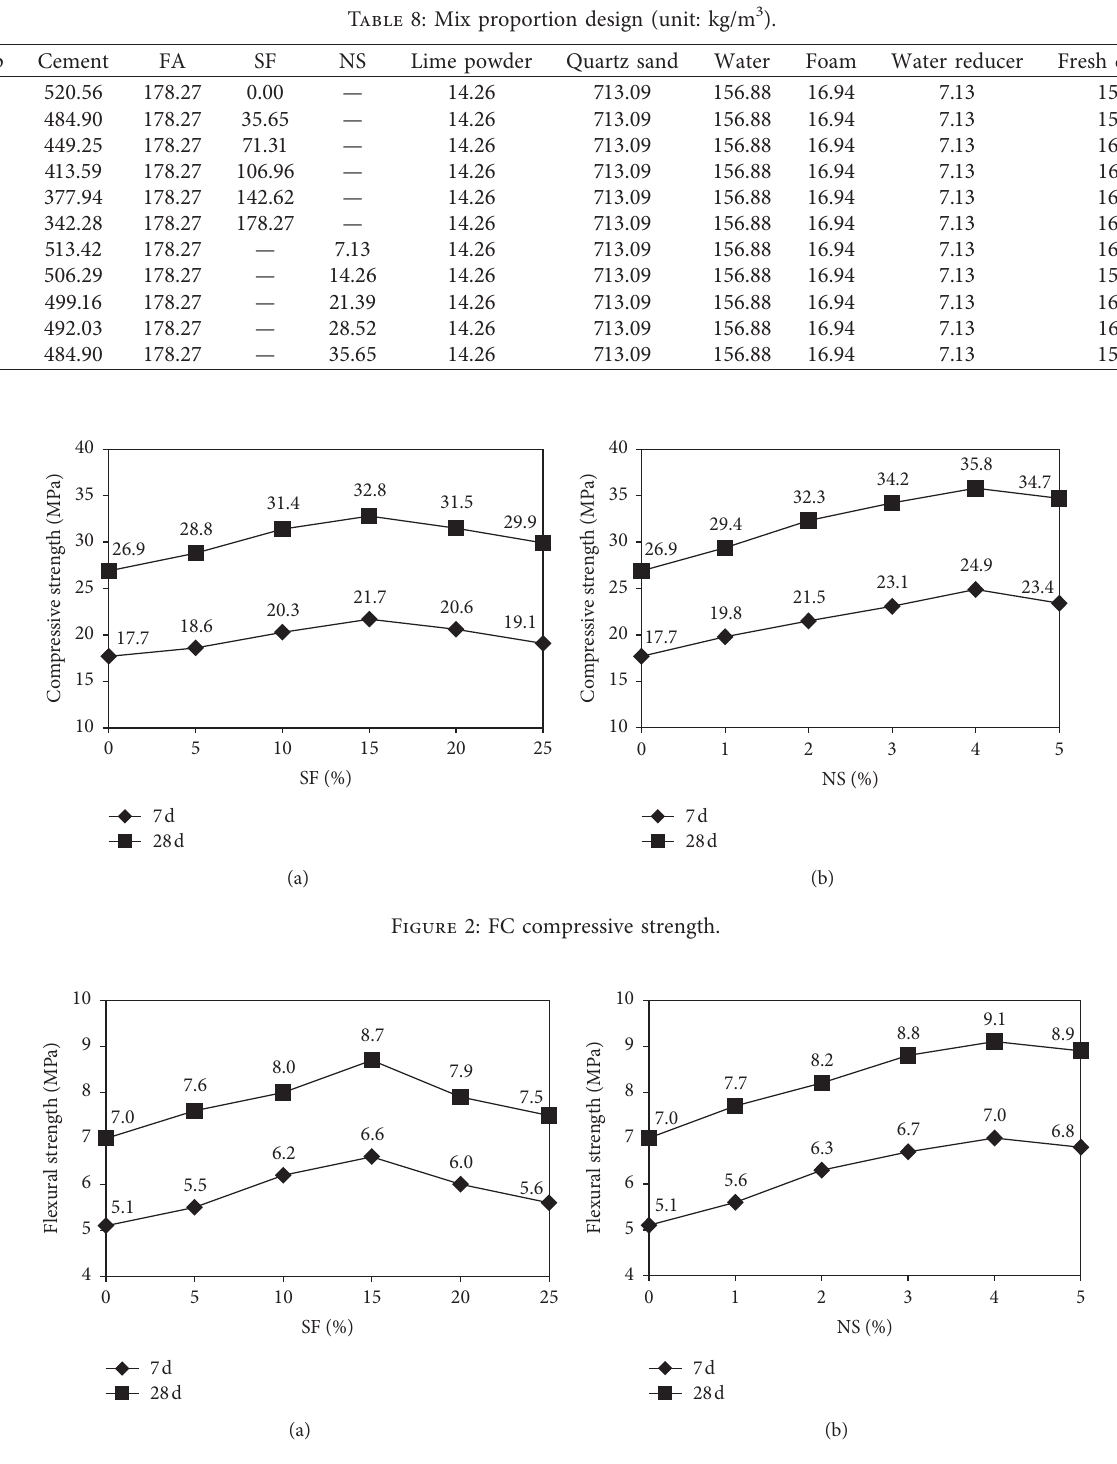
Figure 3: FC flexural